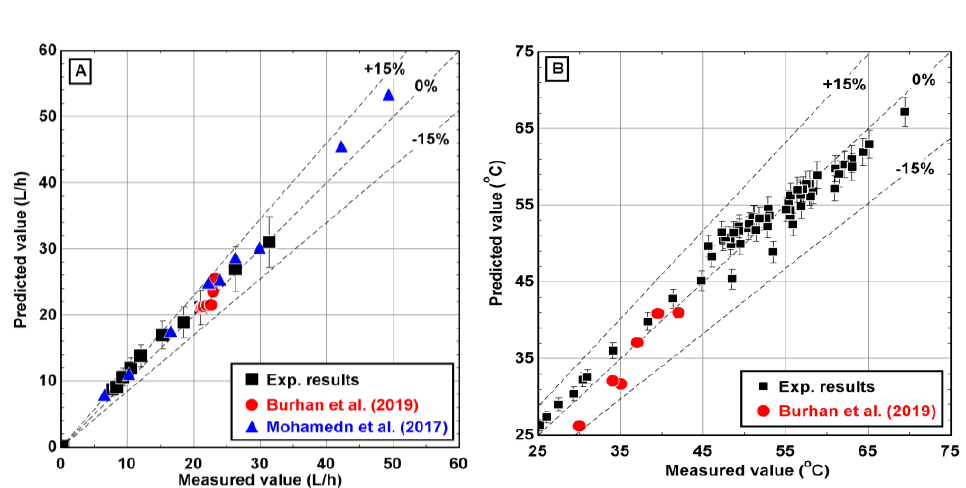
Figure 6. Comparison between experiment measurements and numerical predicted values for ( A ) distillate water flowrates and ( B ) temperatures.